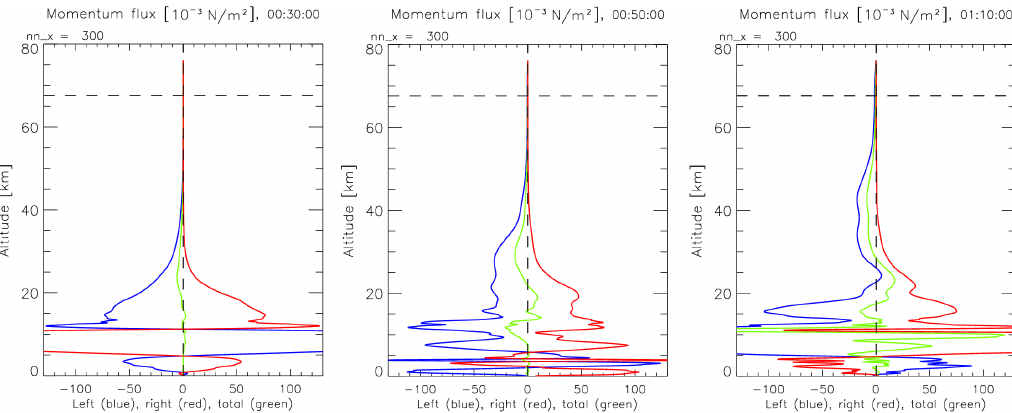
Figure 3. Spatial average of horizontal momentum flux (10 − 3 Nm − 2 ) on the left side (blue), right side (red) and whole domain (green), within a radius of 300km from storm centre, for t = 30, 50 and 70min of integration time.